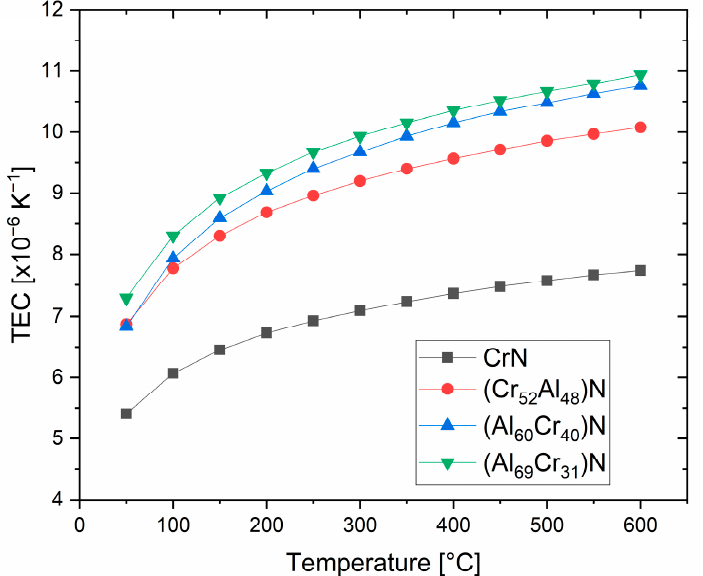
Figure 6. Temperature-dependent thermal expansion coefficients (TECs) of (CrAl)N and (AlCr)N coatings derived from synchrotron experiments, redrawn after [65], original ©